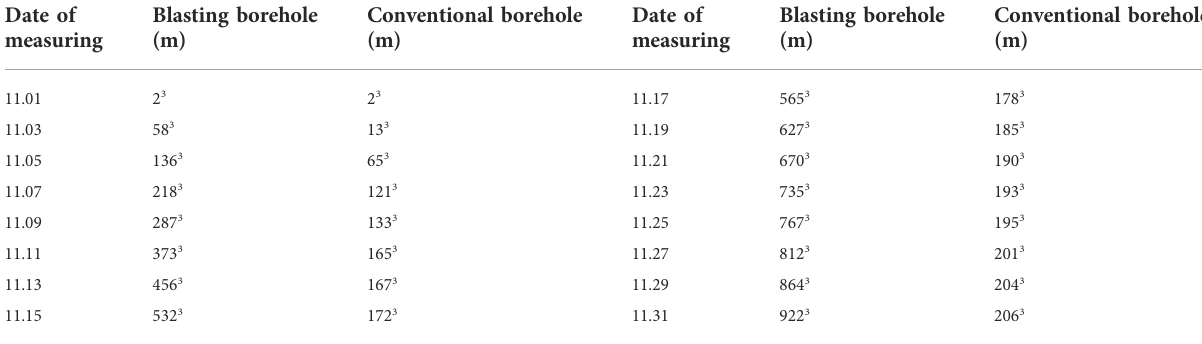
TABLE 6 Cumulative gas extraction volume of blasting boreholes and conventional